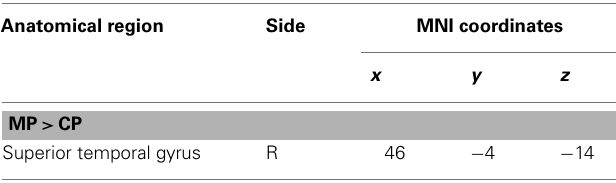
Table 6 | Group activations for the contrast between MP versus CP, p < 0.001, uncorrected.